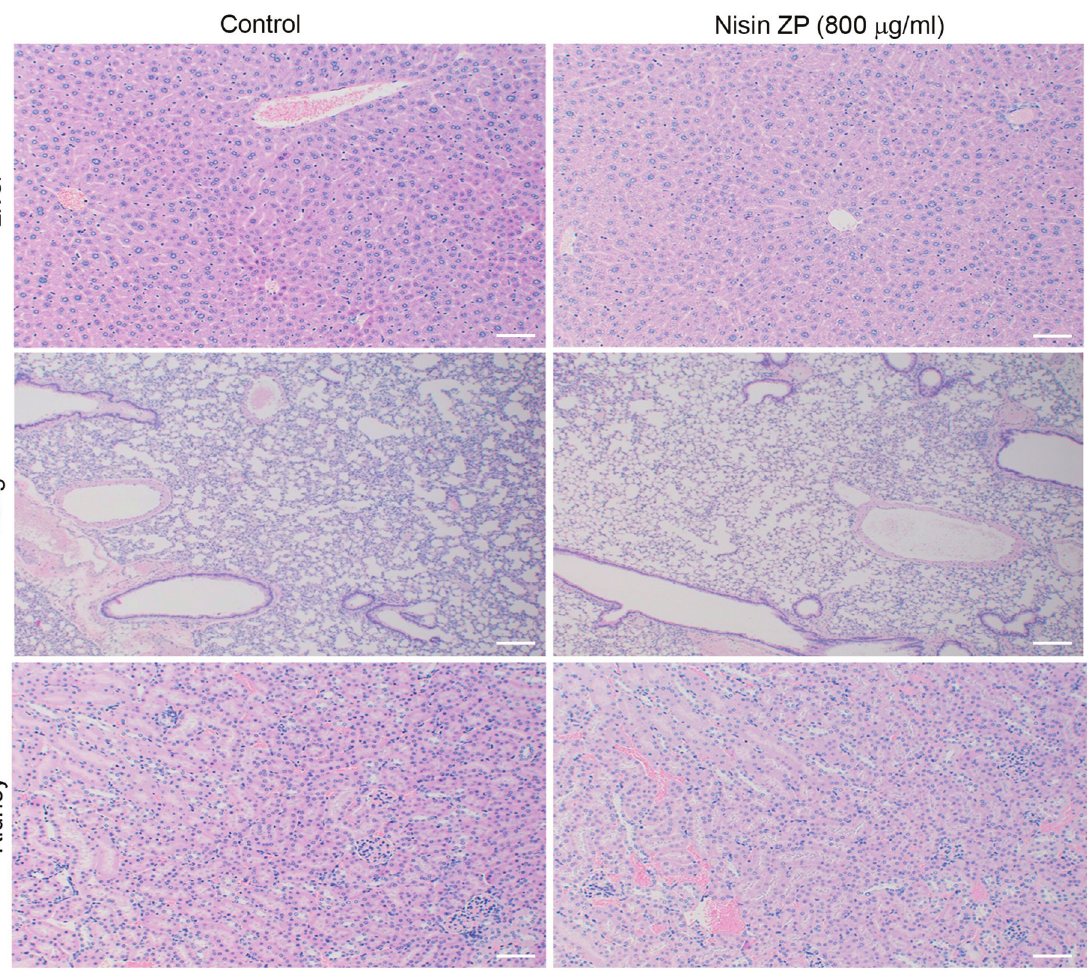
Fig 8. Nisin ZP does not elicit histological signs of toxicity in the liver, lung and kidney of mice. Images of H&E-stained histological sections of liver, lung and kidney from mice injected with UM-SCC-17B cells then treated with either water (control) or nisin ZP (800 mg/kg body weight/day) for 3 weeks.